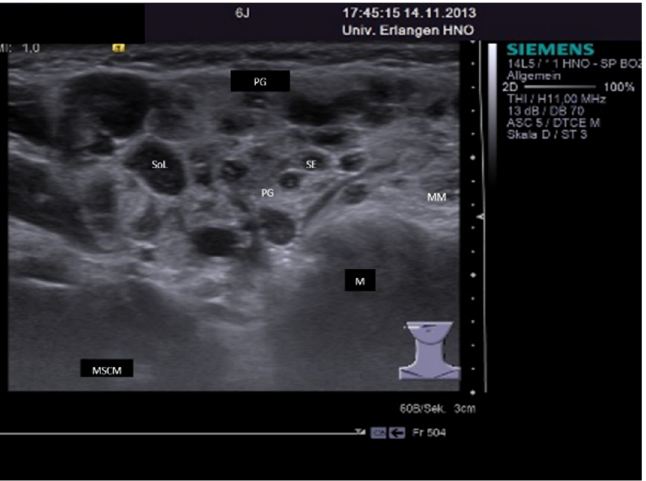
Figure 11. CrjP in a right PG (6-year-old child). The gland is enlarged, and the gland parenchyma is slightly hypoechoic with multiple pronounced hypo-echoic areas, providing a “leopard-skin”-like aspect. Some of the “spots” are nearly echo-free with small hyperechoic reflexes in some parts of the duct corresponding to sialectatic parts. Others are more solid space-occupying lesions corresponding to an infiltration of lymphocytes and plasma cells. Abbreviations: PG, parotid gland; M, mandible; MM, masseter muscle; MSCM, sternocleidomastoid muscle; SoL, space occupying lesion; SE, sialectasia.